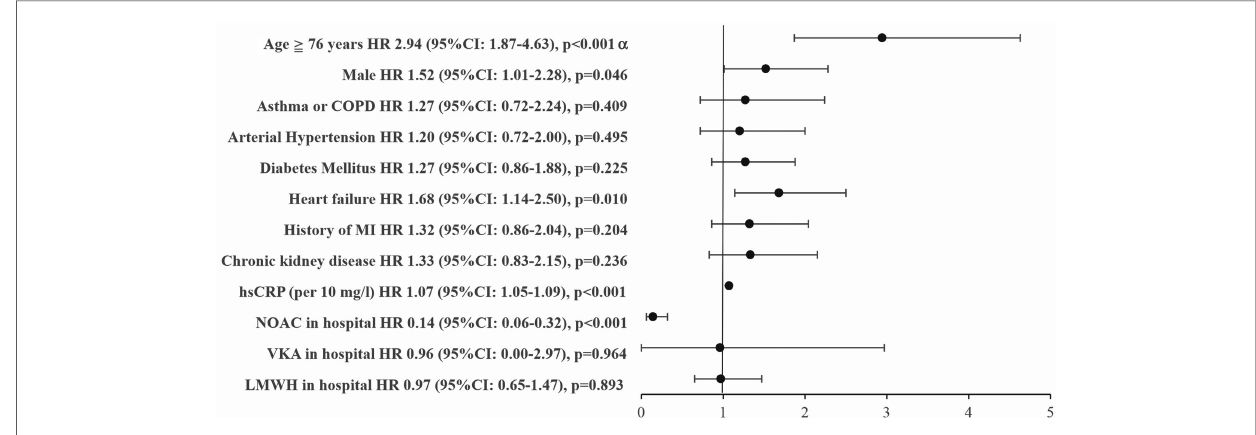
FIGURE 4 Cox regression analysis: independent predictors of 30-day mortality in AF patients, n =421*. * - patients with requirement for mechanical ventilation, renal replacement therapy or those who were treated during hospital stay by two different anticoagulants or were switched within any anticoagulant agent to another (VKA vs. NOACs vs. LMWH) were excluded; α - median for age in AF patients ( n =421) was 76 years. Abbreviations: CI, con fi dence interval; COPD, chronic obstructive pulmonary disease; HR, hazard ratio; hsCRP, high-sensitivity C reactive protein; LMWH, low molecular weight heparin; NOAC, novel oral anticoagulants; VKA, vitamin K